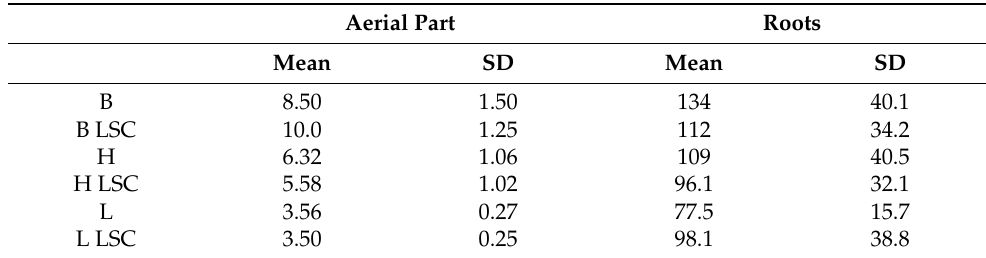
Table 5. Concentration values (mg kg − 1 ) of Pb absorbed by the plants. Values are reported as mean ± standard deviation